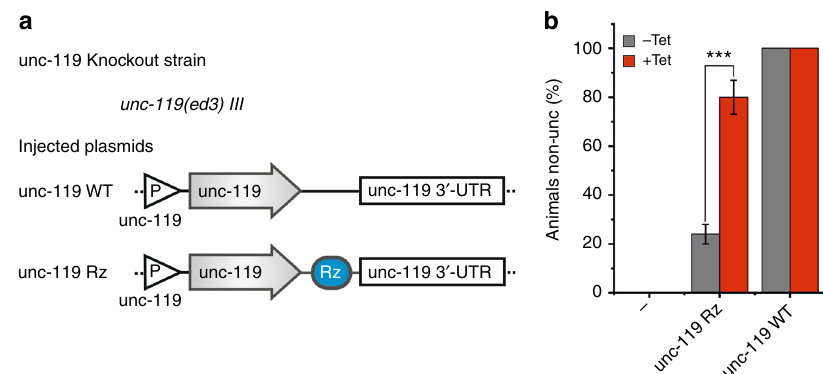
Fig. 5 Aptazymes enable rescue control of mutant phenotypes in C. elegans . a Schematics showing constructs injected into unc-119(ed3) strain. A constitutive unc-119p::Cbr-unc-119 rescue plasmid (unc-119::WT) and a tetracycline-inducible unc-119p::Cbr-unc-119 rescue construct with the aptazyme